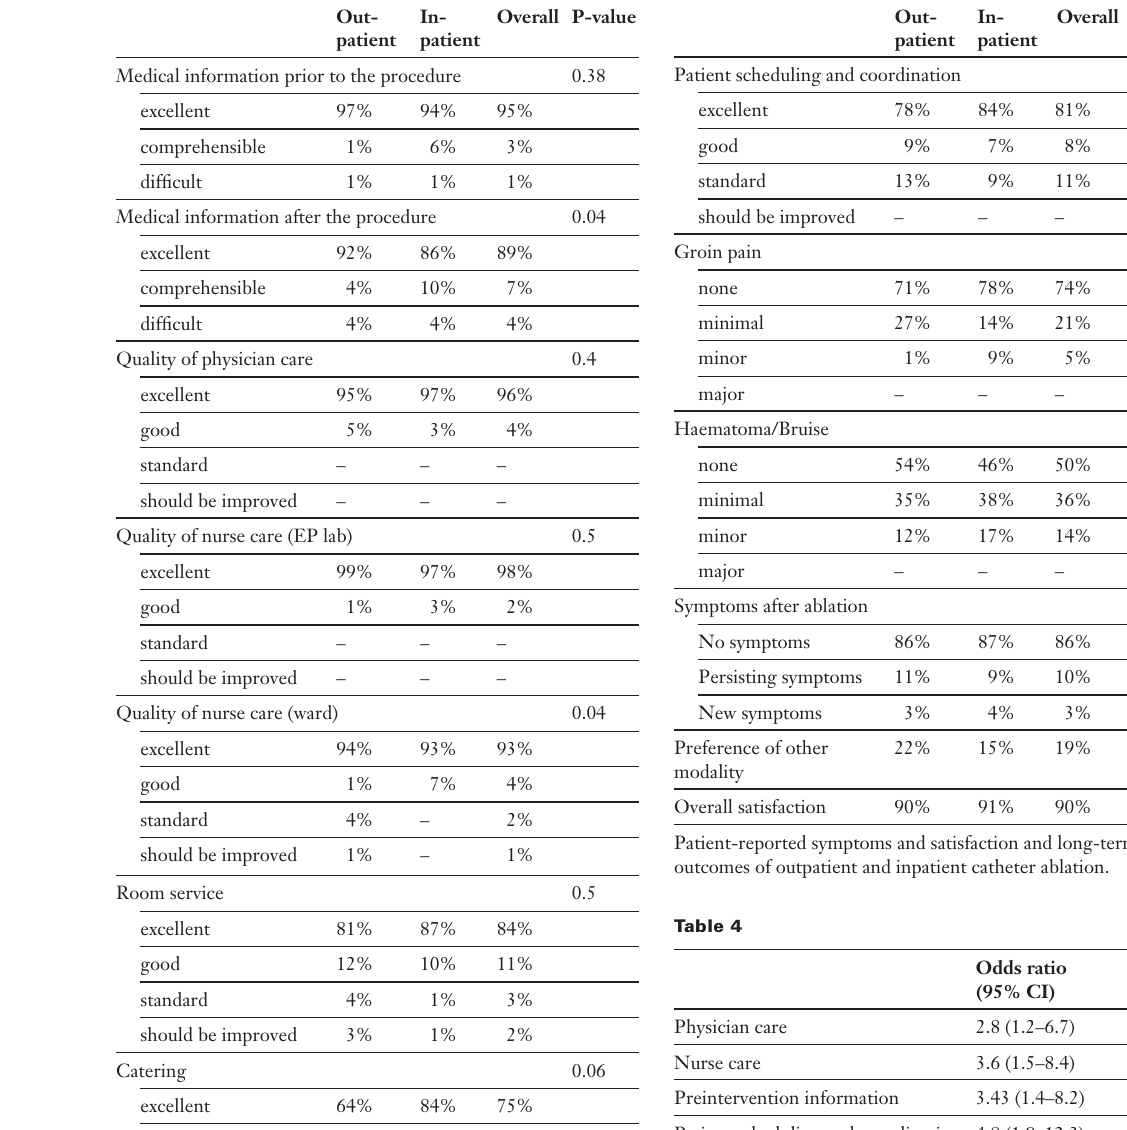
Patient scheduling and